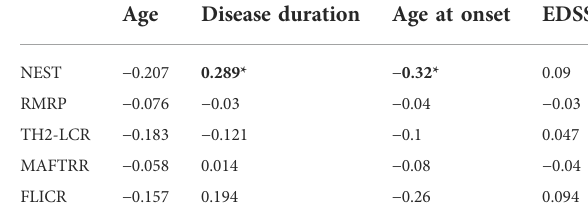
TABLE 7 The results of Spearman ’ s rank correlation between expressions of fi ve lncRNAs and clinical